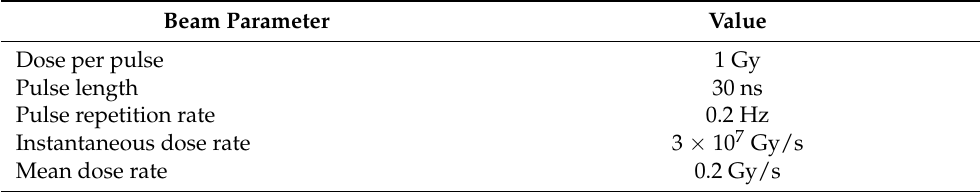
Table 3. Proton beam parameters for cell sample irradiations at the BELLA